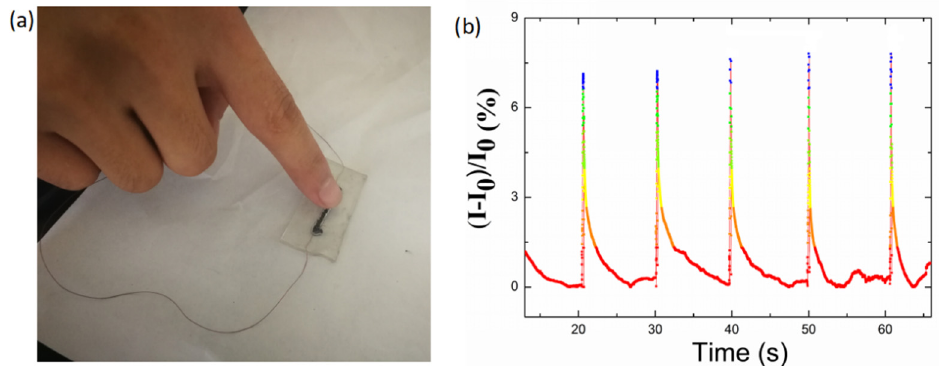
Figure 12. ( a ) Photograph of generating pressure by tapping of the finger. ( b ) Real-time current variation recorded by the TPU / graphene strain sensor with an intertwined-coil configuration for detection of tapping of the finger.